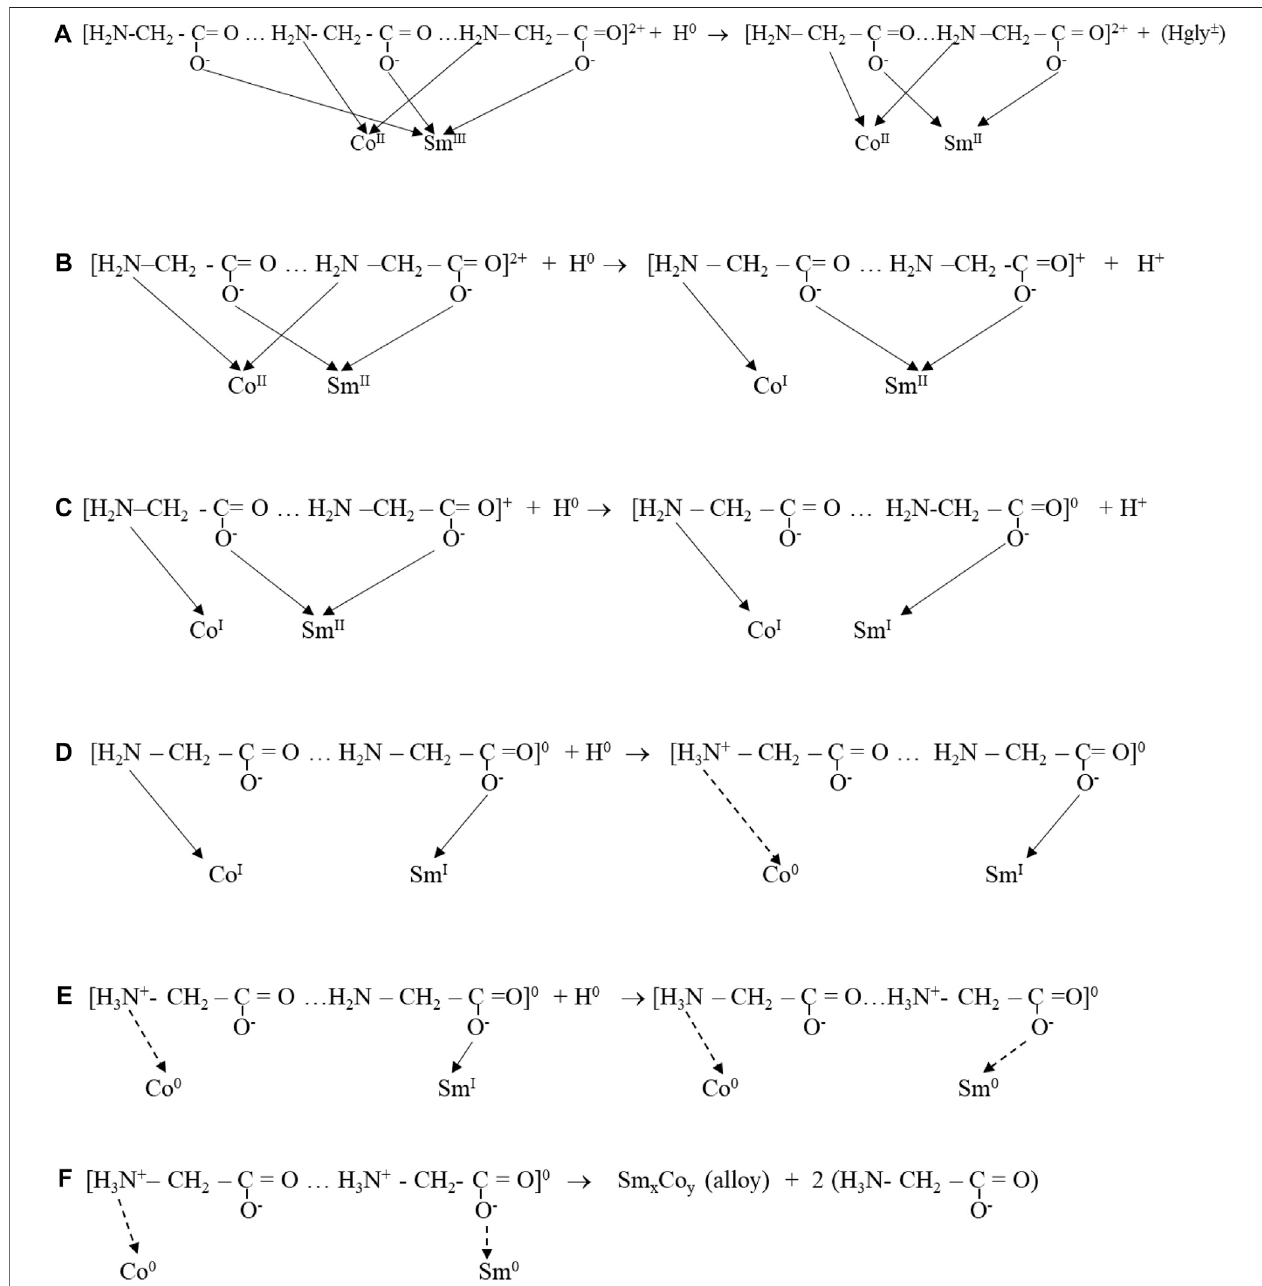
FIGURE 13 | Incremental atomic H reduction of Sm-Co ions in glycine structure.